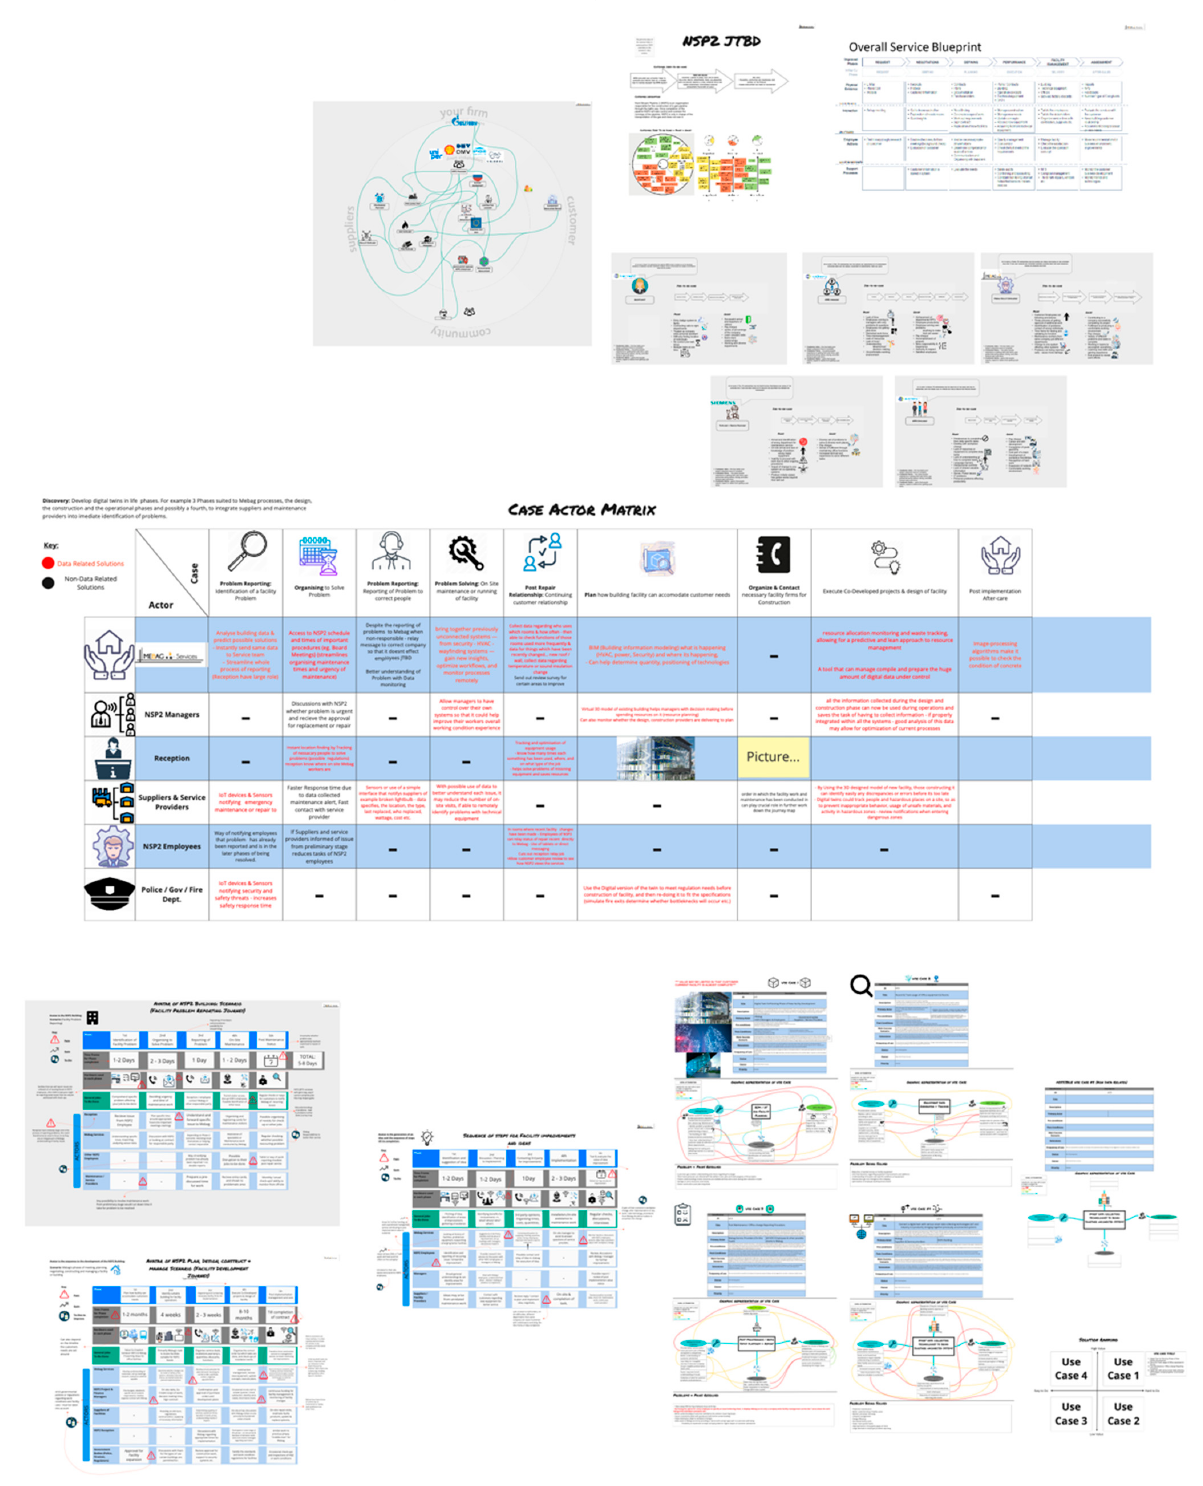
Figure 5. Example of a working from Miro for Case 7, showing the tools and the sketches for the case understanding. Visualization: Stoll, O., & Corcoran, F.